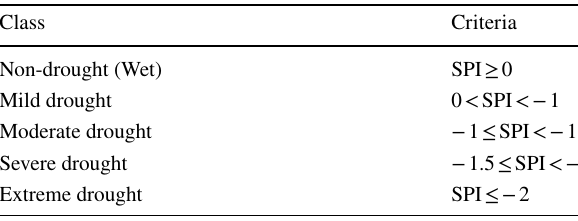
Table 2 Classification of SPI into different drought